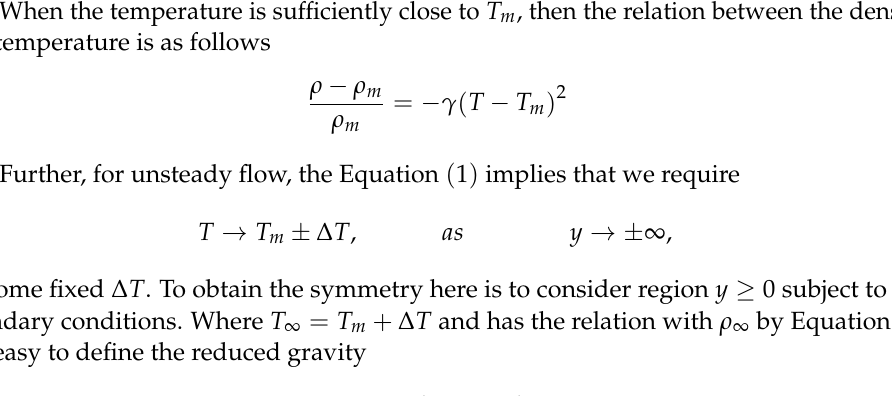
Figure 1. Geometry of horizontal non-conducting cylinder and flow geometry.